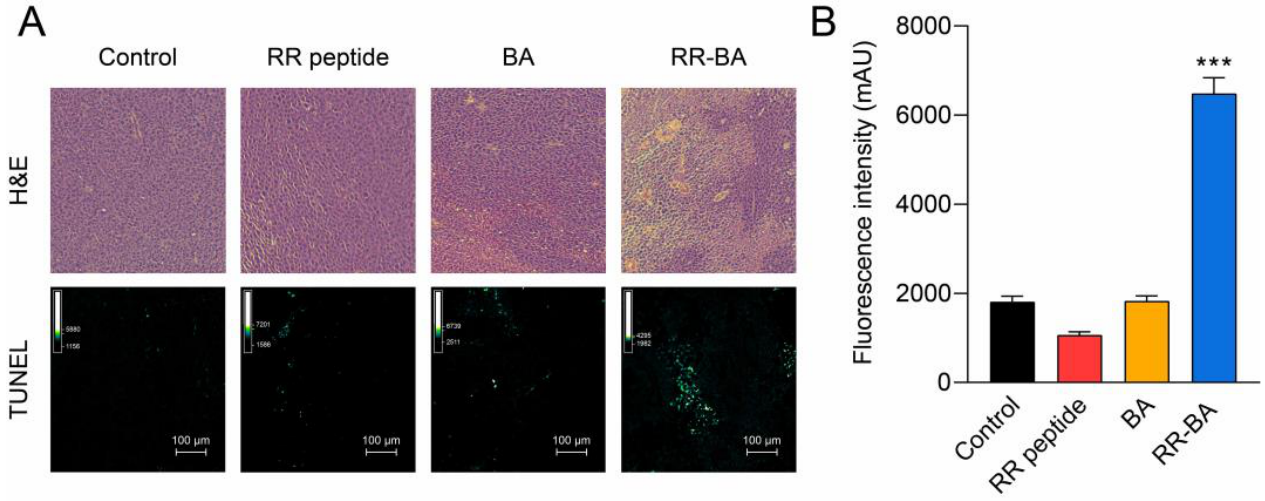
Figure 8. Tumor tissue analysis. ( A ) Images of H&E-stained tumor tissue were histologically analyzed. ( B ) The fluorescence intensity of TUNEL was analyzed quantitatively (*** p < 0.001).